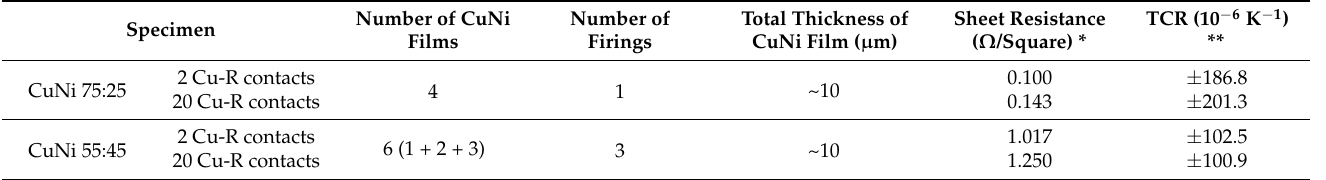
Table 1. Test specimens and results (average of 5 samples for each